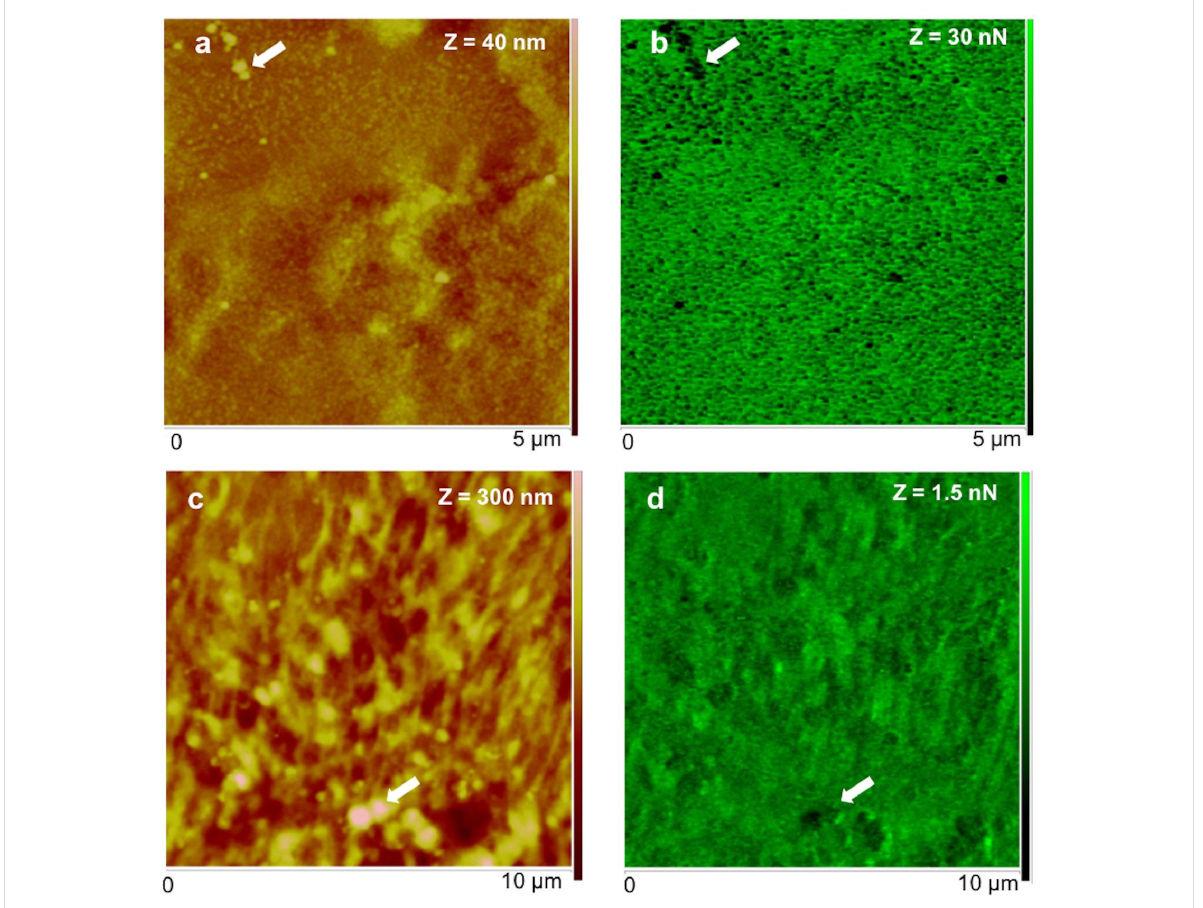
Figure 5: Peak force tapping AFM (PFT-AFM) with quantitative nanomechanical (QNM) software for analysis of height (a, c) and adhesion (b, d) of the adhesive material deposited by the tube feet of Paracentrotus lividus on mica obtained in air (a, b) and artificial seawater (c, d). a) Height and b) adhesion images of dry adhesive material observed in ambient air with a ScanAsyst-Air probe. c) Height and d) adhesion images of wet adhesive material observed in artificial seawater with a ScanAsyst-Fluid probe. Arrows indicate the location of some of the larger globular nanostructures assigned as being most likely adhesive secretory